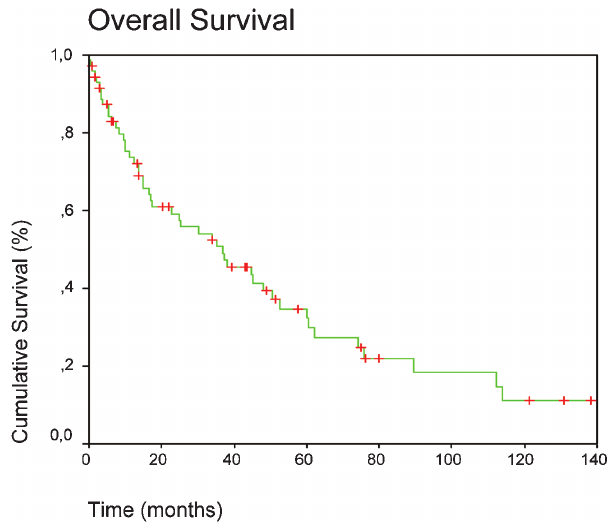
Figure 1 - Overall survival rates for all patients